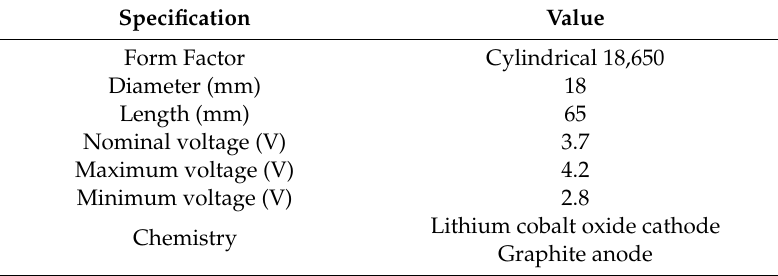
Table 1. Cell specifications.